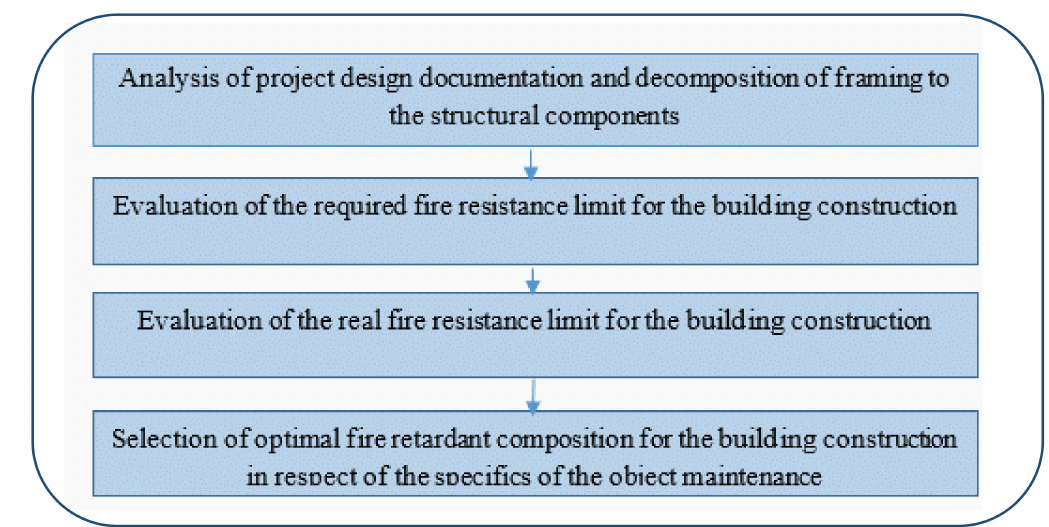
Figure 1. The algorithm of selection of the optimal fire-retardant